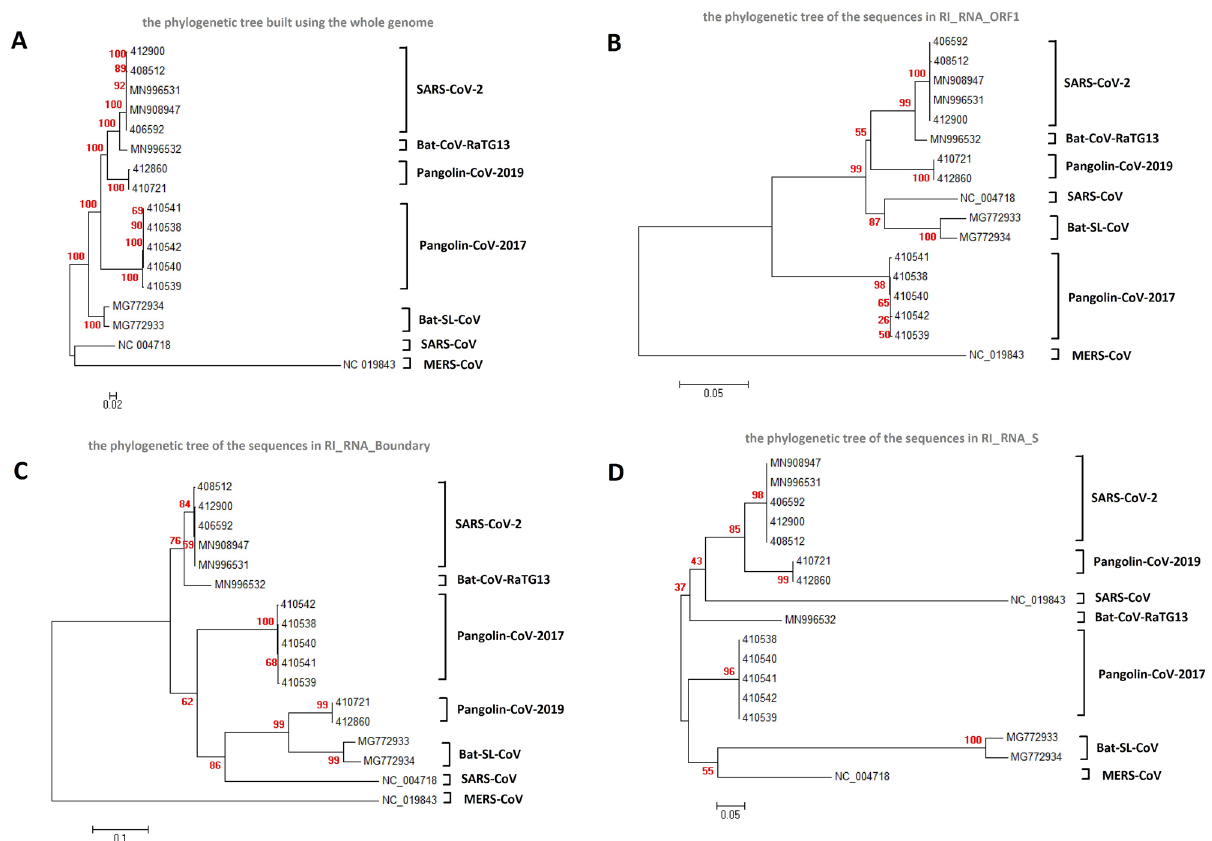
Figure 1. Verification of the three recombination events from phylogenetic trees. ( A ) Whole genome phylogenetic tree. ( B ) Phylogenetic tree built by sequences in RI_RNA_ORF1. ( C ) Phylogenetic tree built by sequences in RI_RNA_Boundary. ( D ) Phylogenetic tree built by sequences in RI_RNA_S. The trees were built using strains related to recombination and related outgroups. The names of the coronavirus to which the strains belong are listed to the right of the phylogenetic tree. The numbers marked in red are the marginal likelihoods of the tree. The trees were built by Mega using the Jukes-Cantor model. Phylogeny tests were performed using the bootstrap method with 5000